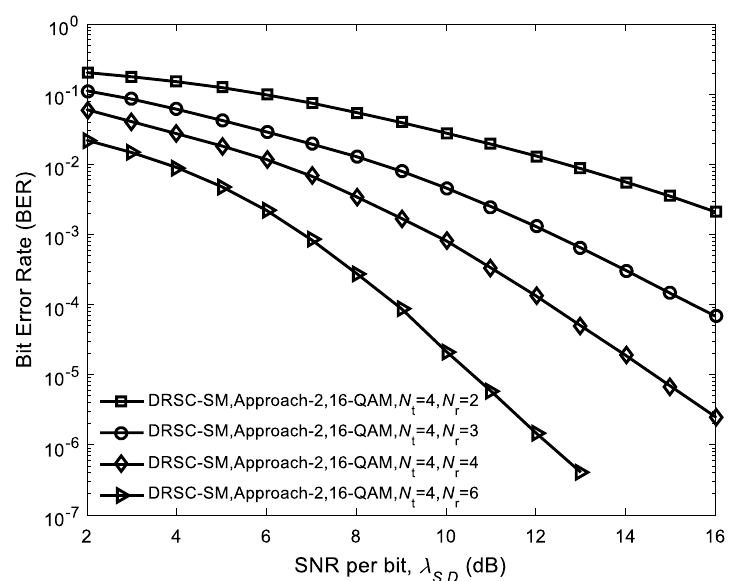
Fig. 16 Performance of DRSC-SM scheme (16-QAM) with various N r employing RS 1 ( 63,61 ) and RS 2 ( 63,41 ) . The solid line with square mark demonstrates the BER performance of DRSC-SM scheme under N r = 2 . The solid line with circle mark demonstrates the BER performance of DRSC-SM scheme under N r = 3 . The solid line with diamond mark demonstrates the BER performance of DRSC-SM scheme under N r = 4 . The solid line with right triangle mark demonstrates the BER performance of DRSC-SM scheme under N r =